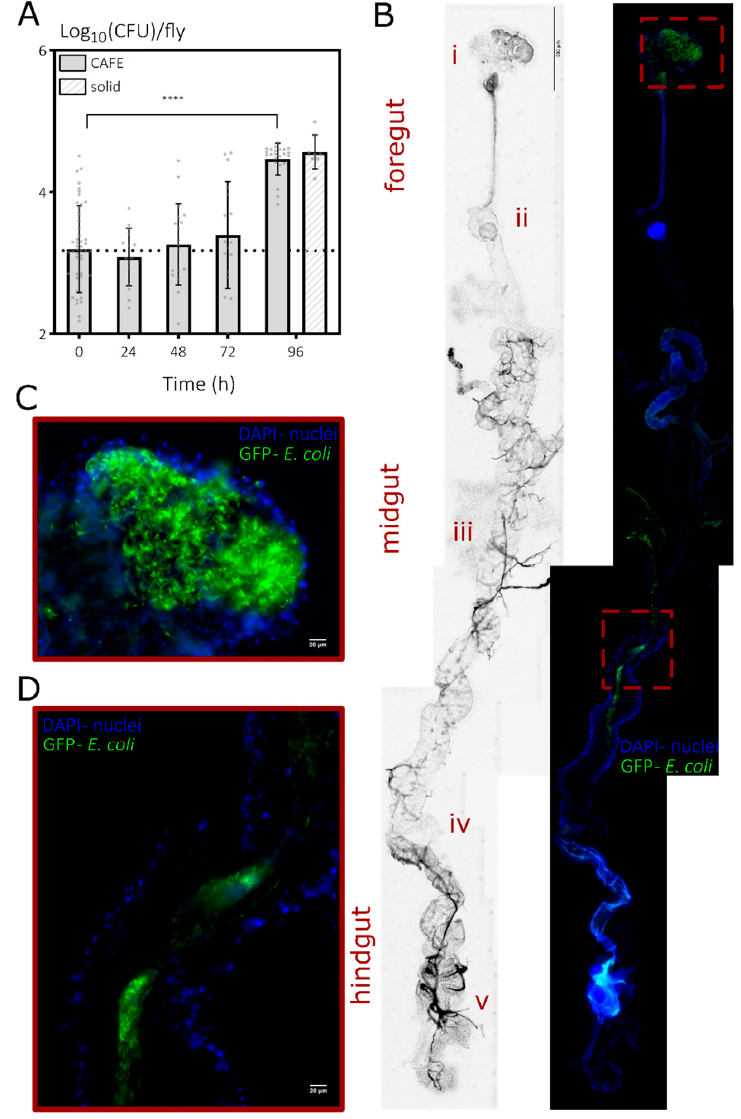
Figure 2. E. coli associates with the gut of D. melanogaster when presented orally to axenic flies. ( A ) Bacterial load of E. coli in the gut of D. melanogaster was measured upon transferring gnotobiotic males (9–10 dpe) to a CAFE setup (full bars) or when flies were maintained on solid food (hatched bar at 96 h). Associations were obtained by feeding axenic, starved male flies (2–3 dpe) with an E. coli inoculum and a subsequent incubation for another week on sterile solid fly food (see Section 2). Timepoint 0 h is before flies were transferred to the CAFE setup. Bacterial loads are normalized per fly (means ± stdevs with n ≥ 8 vials as gray points across ≥ 2 independent runs) and an lme with post hoc test showed a significant increase to the start at 96 h (Dunnett test above bars with ****, p < 0.0001). ( B ) The presence of E. coli in the gut of D. melanogaster was confirmed using microscopy on dissected guts. Widefield images (left) and a composite (right) of DAPI (staining the D. melanogaster nuclei) and GFP (labeling E. coli cells) images of one representative gut at 9–10 dpe (a second one is shown in Figure S3C). The hallmark structures of the crop (i), cardia (ii), copper cell region (iii), Malpighian tubules (iv) and rectal ampulla (v) are highlighted across the 3 main subdivisions of the fly gut. Whereas E. coli cells can be observed in any segment of the gut of gnotobiotic flies, high bacterial densities are specifically found in ( C ) the crop and occasionally in ( D ) other gut regions when associated with the transit of food boluses of which some regions marked with a red square in (B) are magnified. Individual microscopy images were recorded at 20 × magnification at a single plane in z dimension and adjusted to have an equal brightness when stitched together (see Section